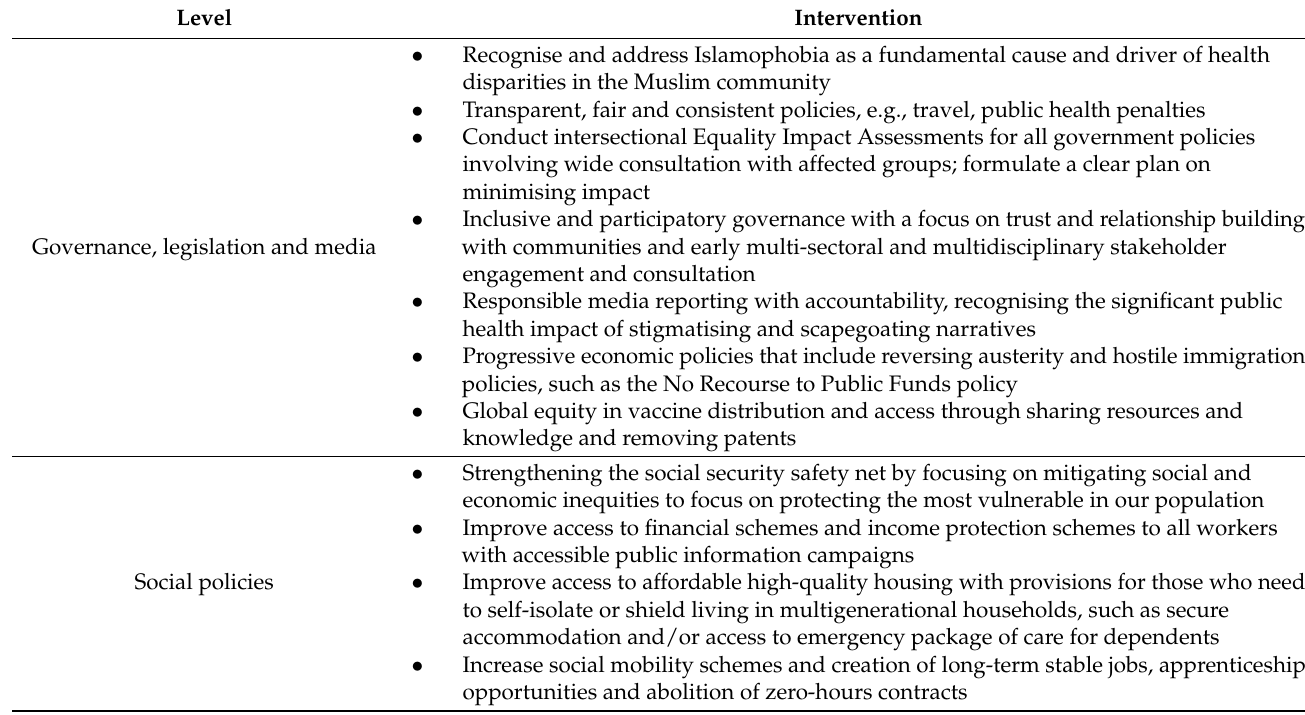
Table 1. Multilevel policy responses to mitigate risks and eliminate health inequities in the Muslim community in